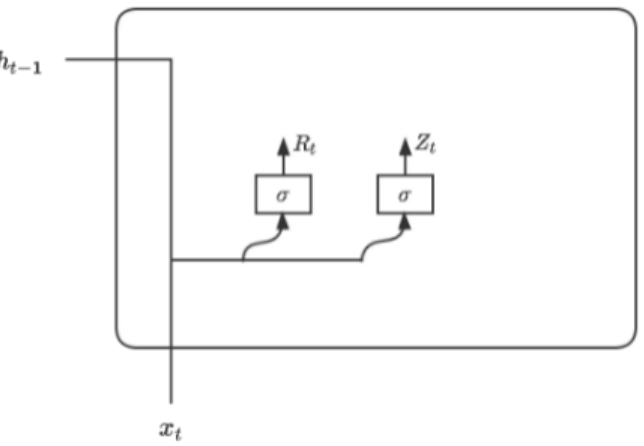
Figure 2. Reset gate and update gate structure of GRU.